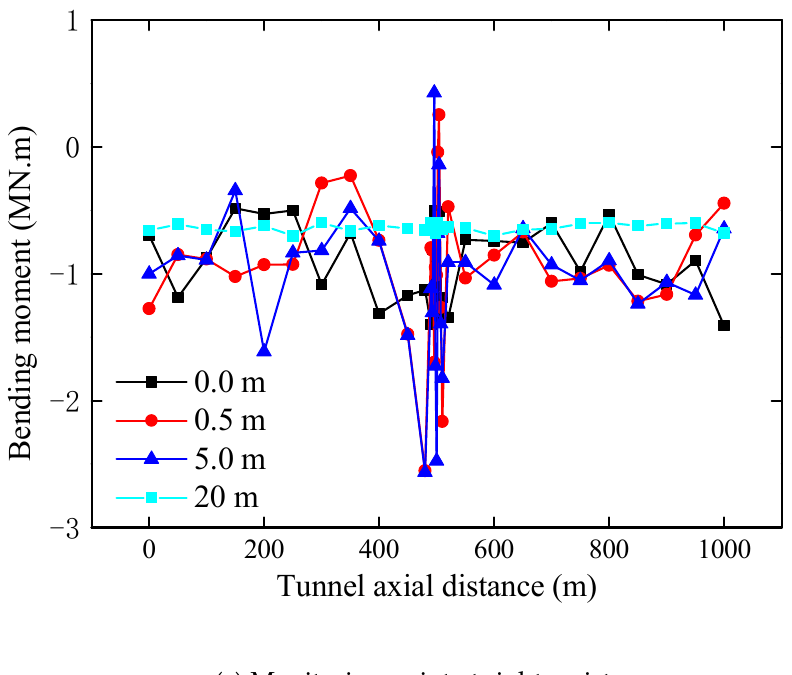
Figure 8. Bending moment of the lining monitoring points of the tunnel passing through adverse geological structure zone with different thicknesses along the tunnel axial direction.